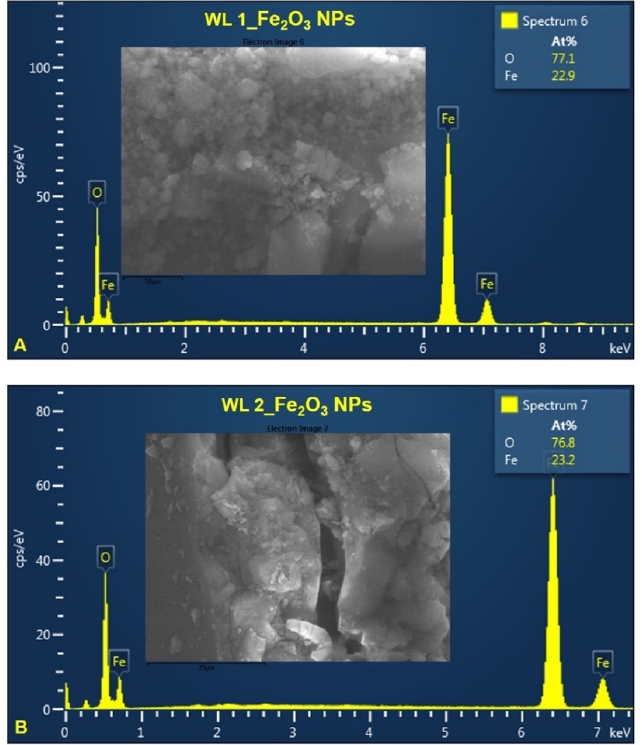
Figure 6. SEM images of IONPs obtained from wormwood stems aqueous extract (WS 1–at 80 °C and WS 2–at 25 °C), at different orders of magnitude: ( A , C ) 500 nm scale bar, ( B , D ) 100 nm scale bar.